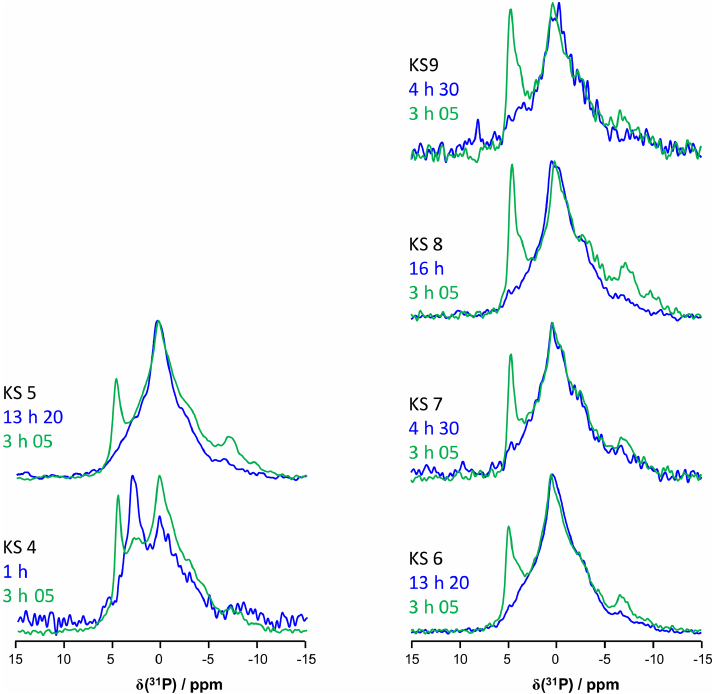
Figure A4. 31 P MAS and CP MAS NMR spectra of all KSs presented in this work (700MHz).